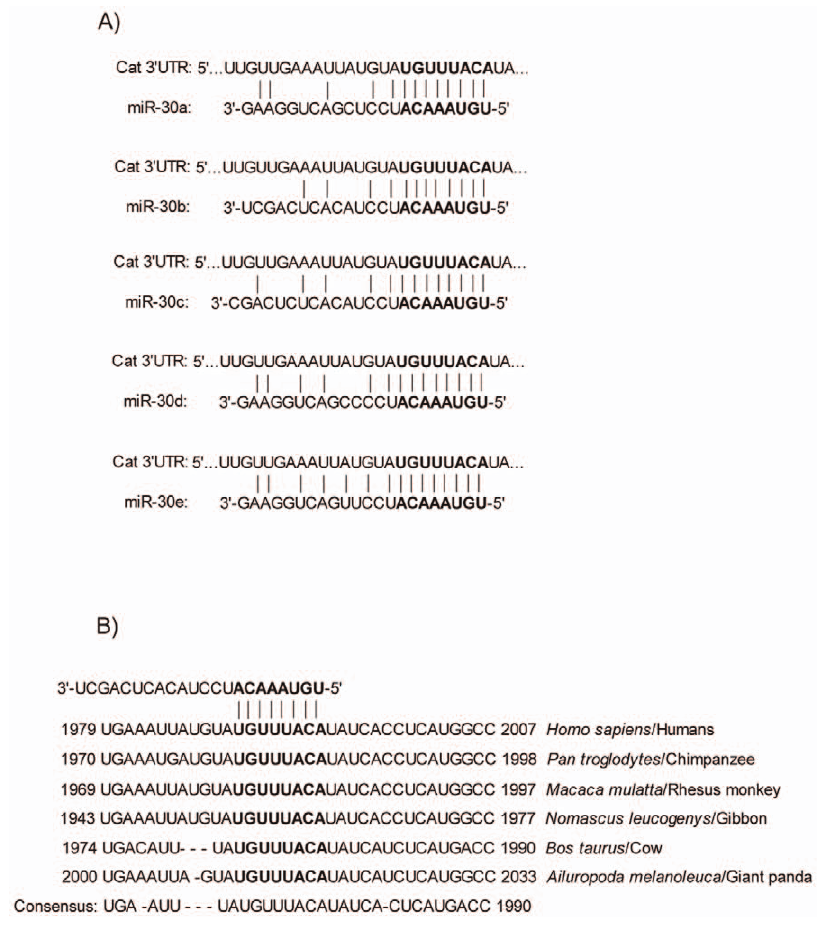
Figure 1. The human catalase 3 9 -UTR contains one putative miRNA binding site for the members of miR-30 family. Panel A: Complimentarity between the members of miR-30 family and the putative human catalase 3 9 -UTR site targeted (318–324 bp downstream from the human catalase stop codon). Panel B: The potential binding sequences for miR-30b within the catalase 3 9 -UTR of human ( H. sapiens ), chimpanzee ( P. troglodytes ), rhesus monkey ( M. mulatta ), gibbon ( N. leucogenys ), cow ( B. taurus ), and giant panda ( A. melanoleuca ). The 8 bp seed sequences of miR- 30 and the putative target site in catalase 3 9 -UTR in both the panels are highlighted in bold.